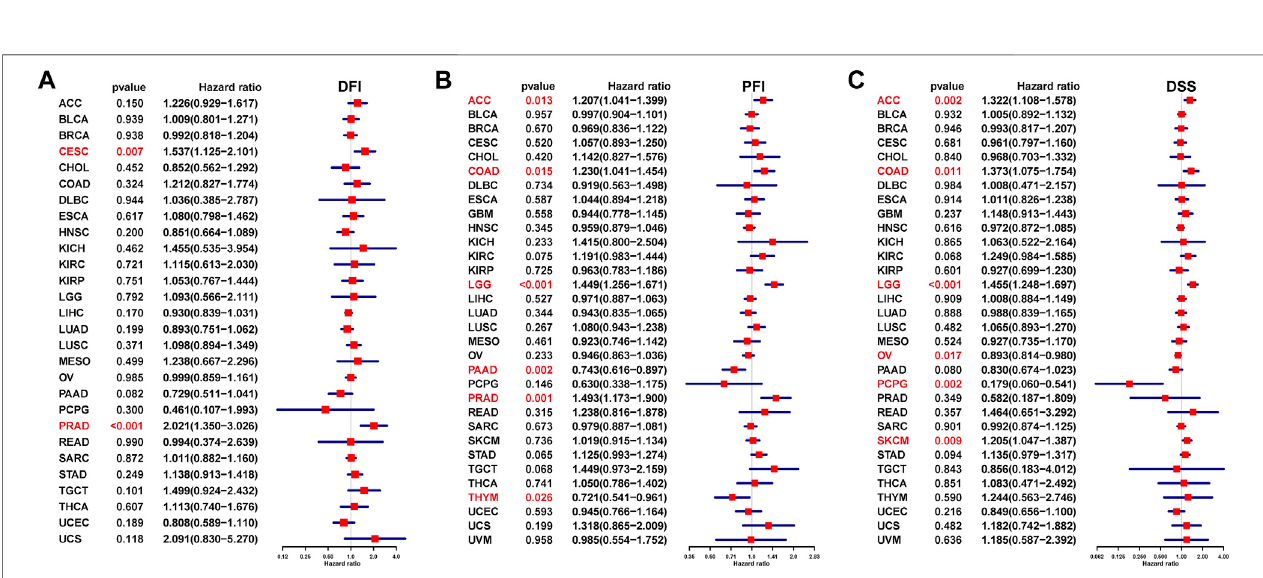
FIGURE 5 | Prognostic value of ISYNA1. (A) The UniCox OS analysis of ISYNA1 in TCGA pan-cancer. Red represents signi fi cant results ( p < 0.05). (B) Kaplan – Meier OS analysis of ISYNA1 in TCGA pan-cancer in indicated tumor types.